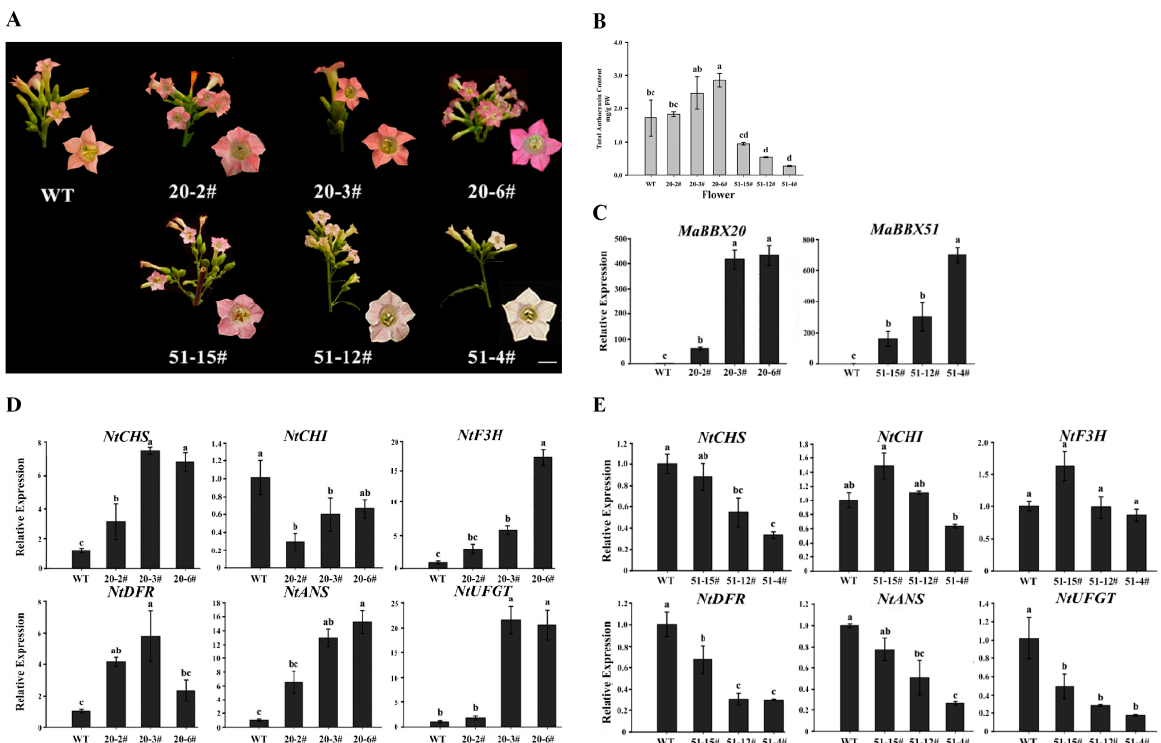
Figure 5. Functional analysis of MaBBX20 and MaBBX51 in the tobacco plant. ( A ) Flower phenotypes of overexpressing transgenic lines. Three independent transgenic lines were used for each gene. Scale bar: 2 mm. ( B ) Anthocyanin content in tobacco corollas of transgenic lines. FW, fresh weight. ( C ) qPCR analysis of MaBBX20 and MaBBX51 expression in the corollas of their transgenic